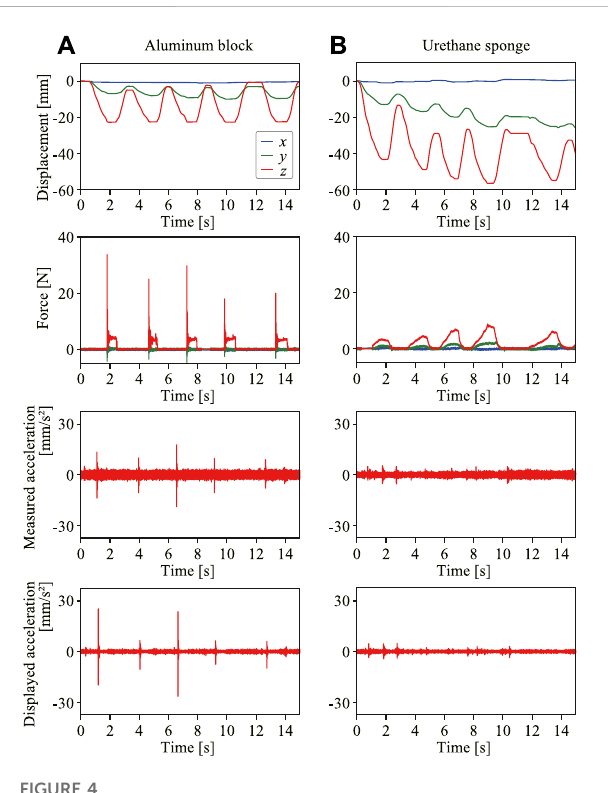
Examples ofmeasuredforceand vibration signals usingpush touch mode in Experiment